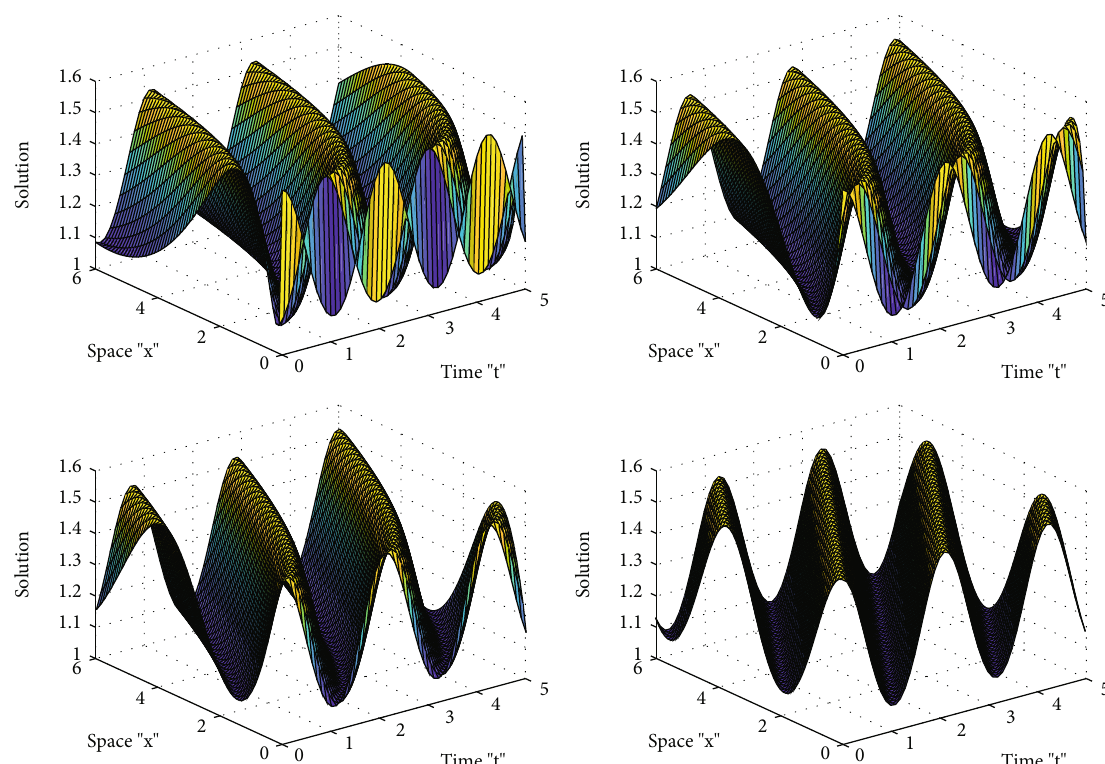
Figure 3: 3D plot of Equation (28) with σ = 0 and di ff erent α